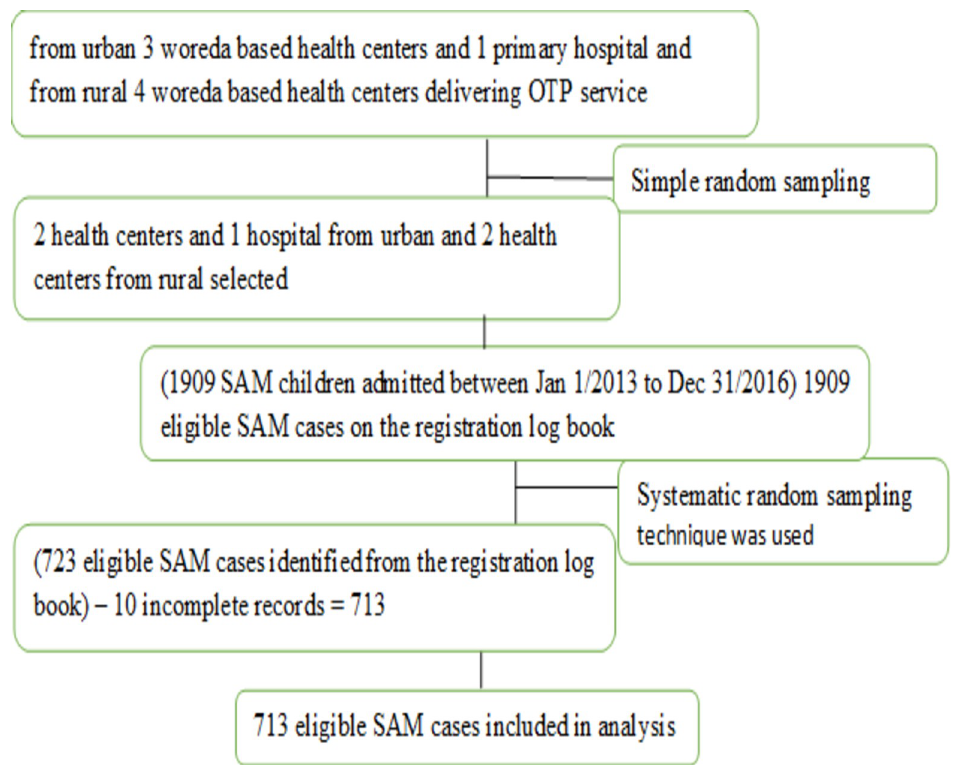
Fig 1. Sampling scheme of severe acutely malnourished children included in the study. Simple random sampling was used to select health centers. In the selected health centers, systematic random sampling was used to select eligible SAM children. SAM refers to Severe Acute Malnutrition and OTP refers to Outpatient Therapeutic Care